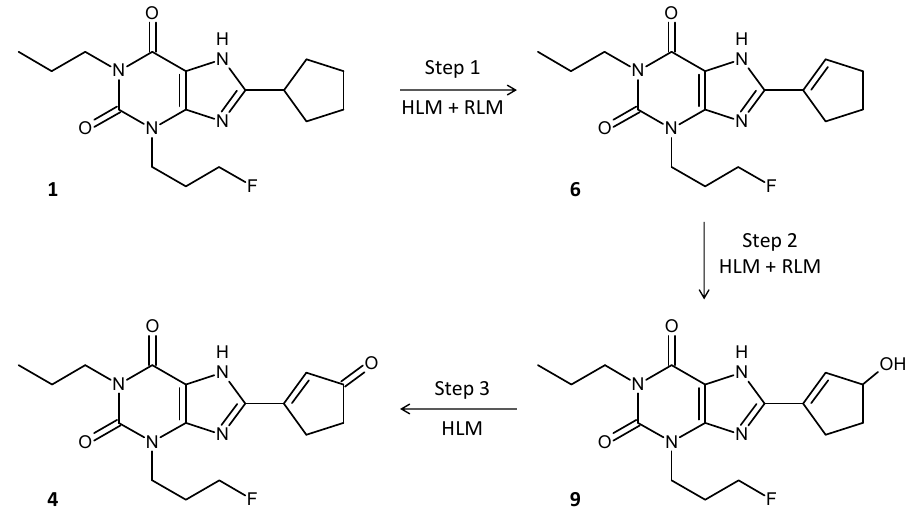
Figure 9. Proposed biotransformation pathway of CPFPX ( 1 ) in human liver microsomes. A three-step oxidation sequence transforms the parent compound into the enone metabolite ( 4 ). In rat liver microsomes, only reaction steps 1 and 2 take place, but not the final oxidation step 3, which converts the hydroxy intermediate ( 9 ) into the enone.